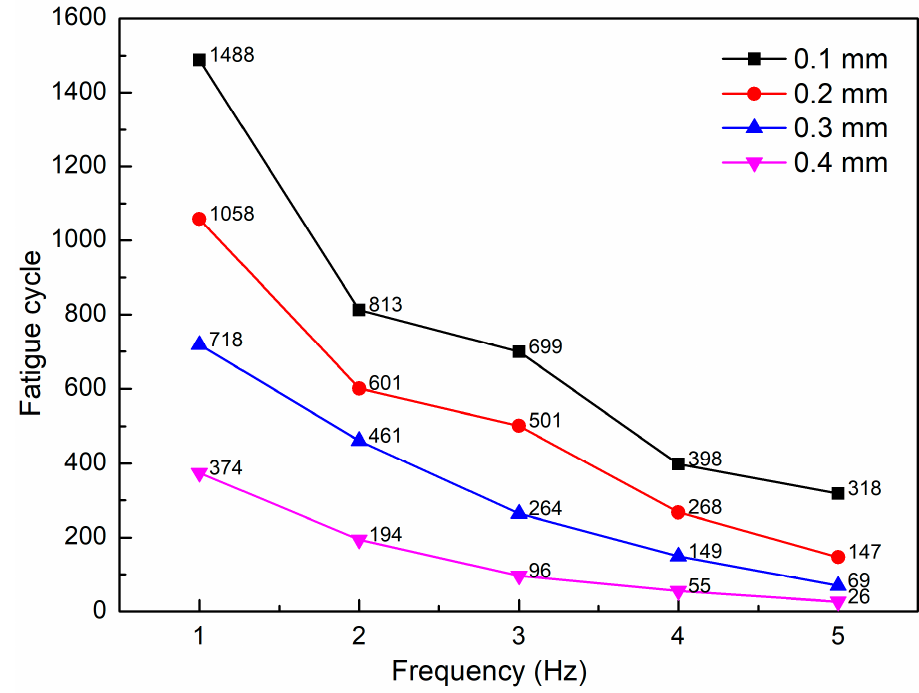
Figure 6. Fatigue cycle vs. frequency of PP samples at different amplitudes and frequencies.